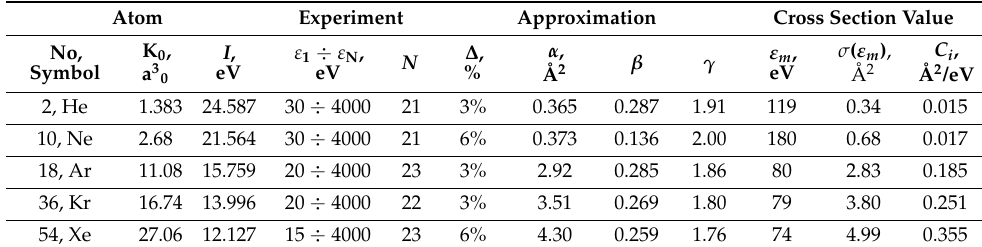
Table 2. Characteristics of noble gas atoms, error and parameters of approximation, general charac- teristics of cross sections according to the found approximations.